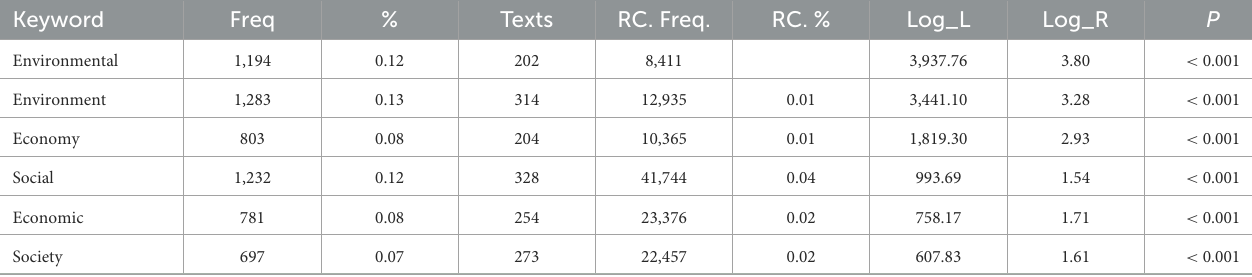
TABLE 1 Statistics of keywords related to the three sustainability dimensions.